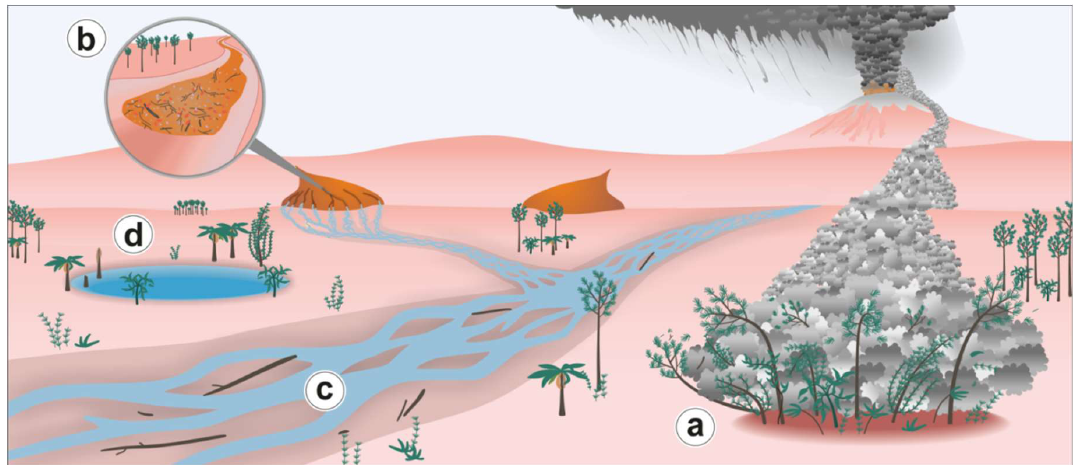
Figure 1. Petrified-wood forming environments of the late Paleozoic in Central Europe. ( a ) In situ burial in pyroclastic deposits (Flöha, Wendishain, Chemnitz). ( b ) Alluvial transport and burial by mass flows with/without volcanic material (Winnweiler). ( c ) Reworking and burial of stems in fluvial deposits (Kyffhäuser). ( d ) Silicification in lacustrine and palustrine environments (Manebach).